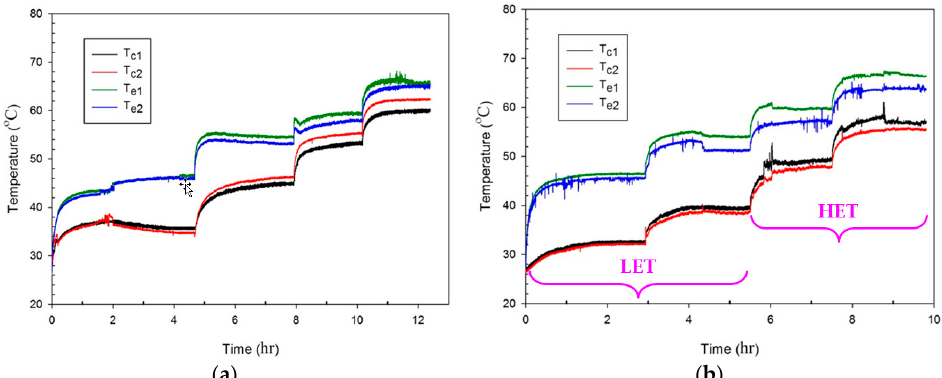
Figure 6. Variation of surface temperature in both evaporating section and condensing section of the PHP heat exchanger charged with ( a ) HFE-7000 after degassing, and ( b ) water, with time at hot air inlet temperatures stepwise increased from 55 to 100 °C with filling ratio of 35% at airflow velocity of 0.5 m/s. Table 2. Thermophysical properties of the working fluid at 75 °C unless otherwise specified.